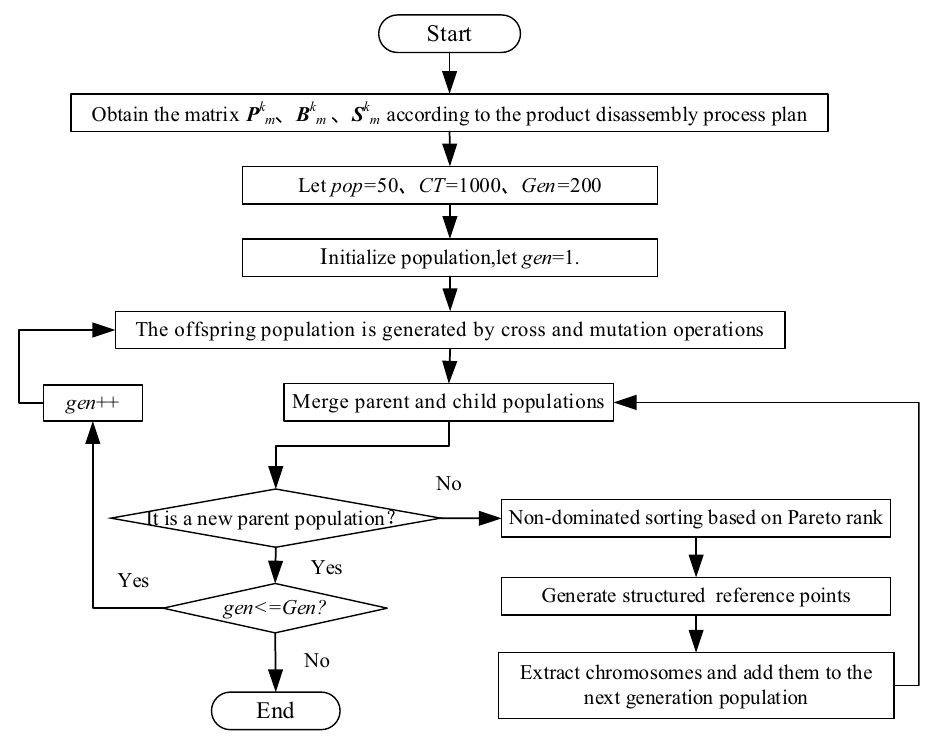
Figure 5. Flowchart for the PMRDLB problem solution